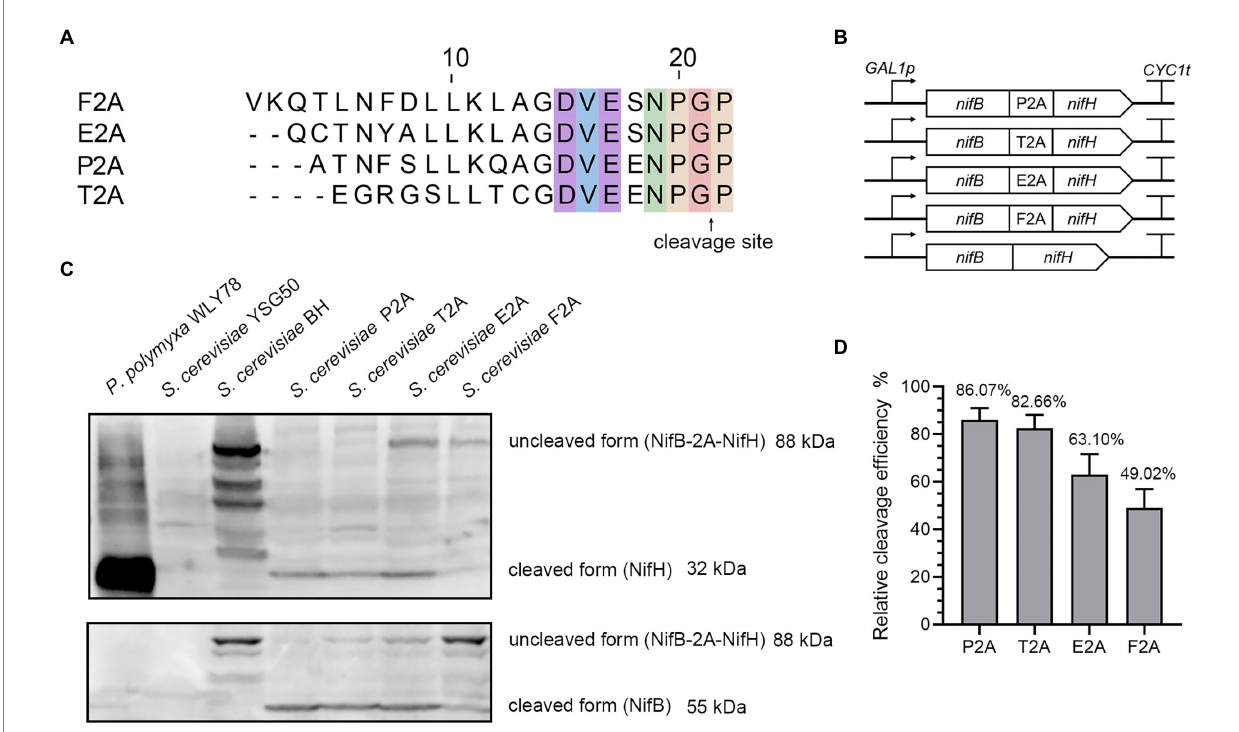
FIGURE 1 The cleavage efficiency of NifB and NifH linked via four different 2A sequences. (A) Amino acid sequences of the 2A peptides used in this study. (B) Schematic diagrams of the constructs of nifB and nifH linked via 4 different 2A peptides and without 2A peptide in the recombinant vectors. GAL1p indicates promoter and CYC1t indicates terminator. (C) Western blotting analysis of cell homogenates using antibody against NifH and NifB, respectively. P . polymyxa WLY78 was used as a positive control. The recipient S . cerevisiae YSG50 and S . cerevisiae BH carrying NifB-NifH fusion protein without 2A peptide linker are used as negative controls. P2A, T2A, E2A, and F2A indicate that S . cerevisiae strains carrying NifB-NifH fusion protein linked via P2A, T2A, E2A, and F2A, respectively. (D) Quantitation of the cleavage efficiency of NifB and NifH mediated by different 2A sequences. Cleavage efficiency = NifH/ (NifH+NifB-2A-NifH) *100%. The band intensity on the Western blot was measured by ImageJ software. Error bars indicated SEM, n =